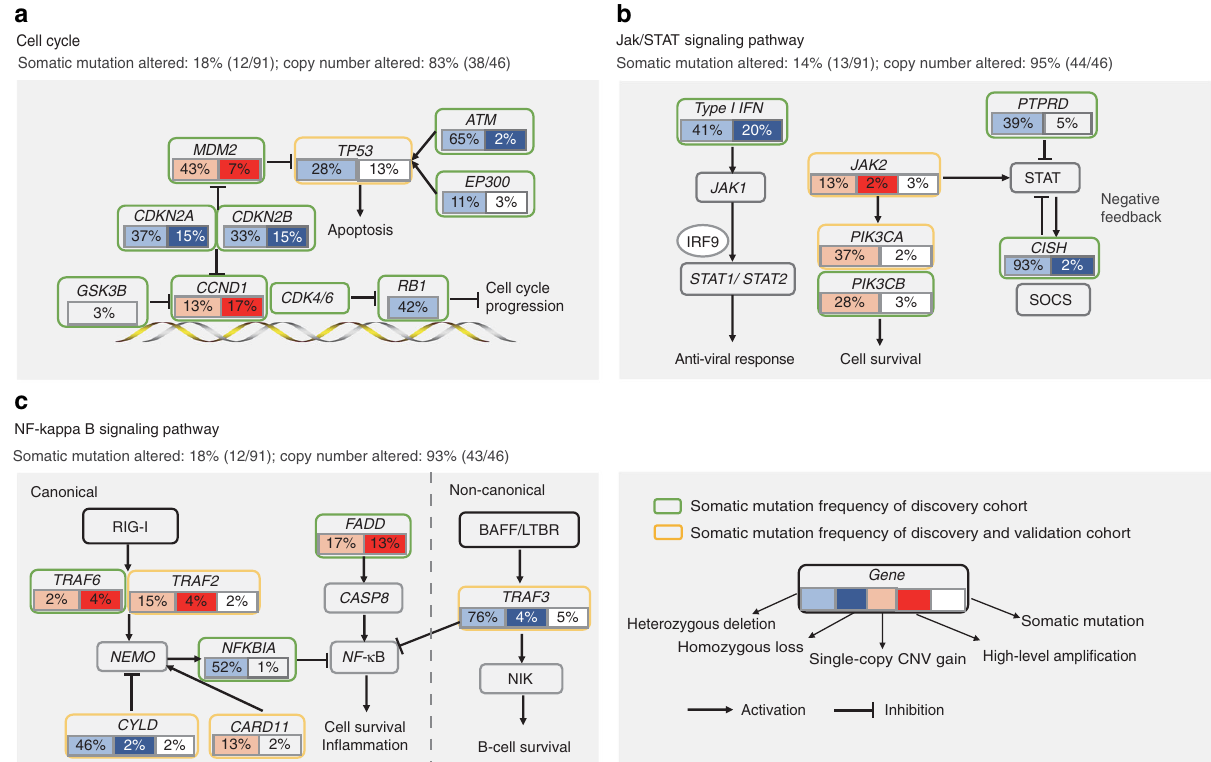
Fig. 3 Altered pathways in pulmonary LELC. Alterations de fi ned as somatic mutations, focal ampli fi cations, and deletions affecting Cell cycle ( a ), JAK/ STAT ( b ), and NF-kappa B ( c ) signaling pathways are shown. Alteration frequencies are expressed as a percentage of samples form discovery cohort and validation cohort. LELC, lymphoepithelioma-like carcinoma NATURE COMMUNICATIONS| (2019) 10:3108